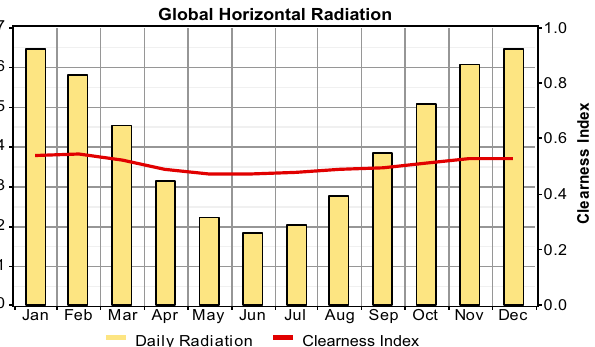
Fig. 3. Daily average solar radiation in Geelong area.